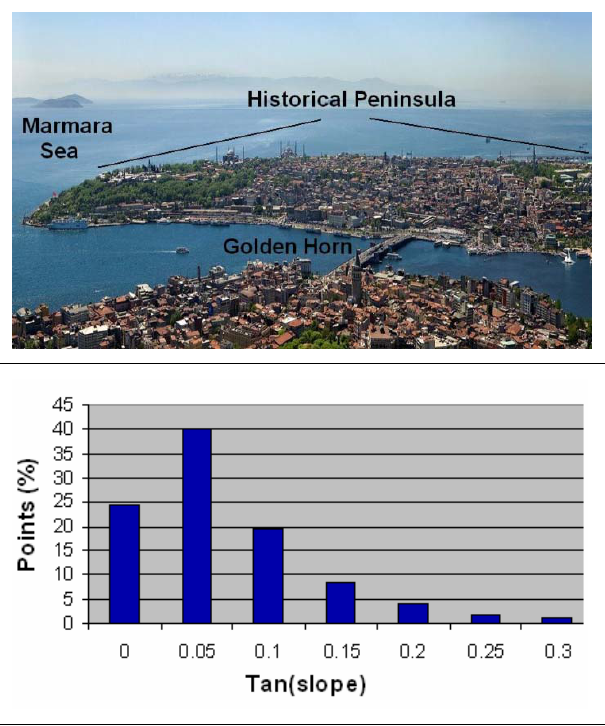
Figure 1. Historical Peninsula and the frequency distribution of terrain